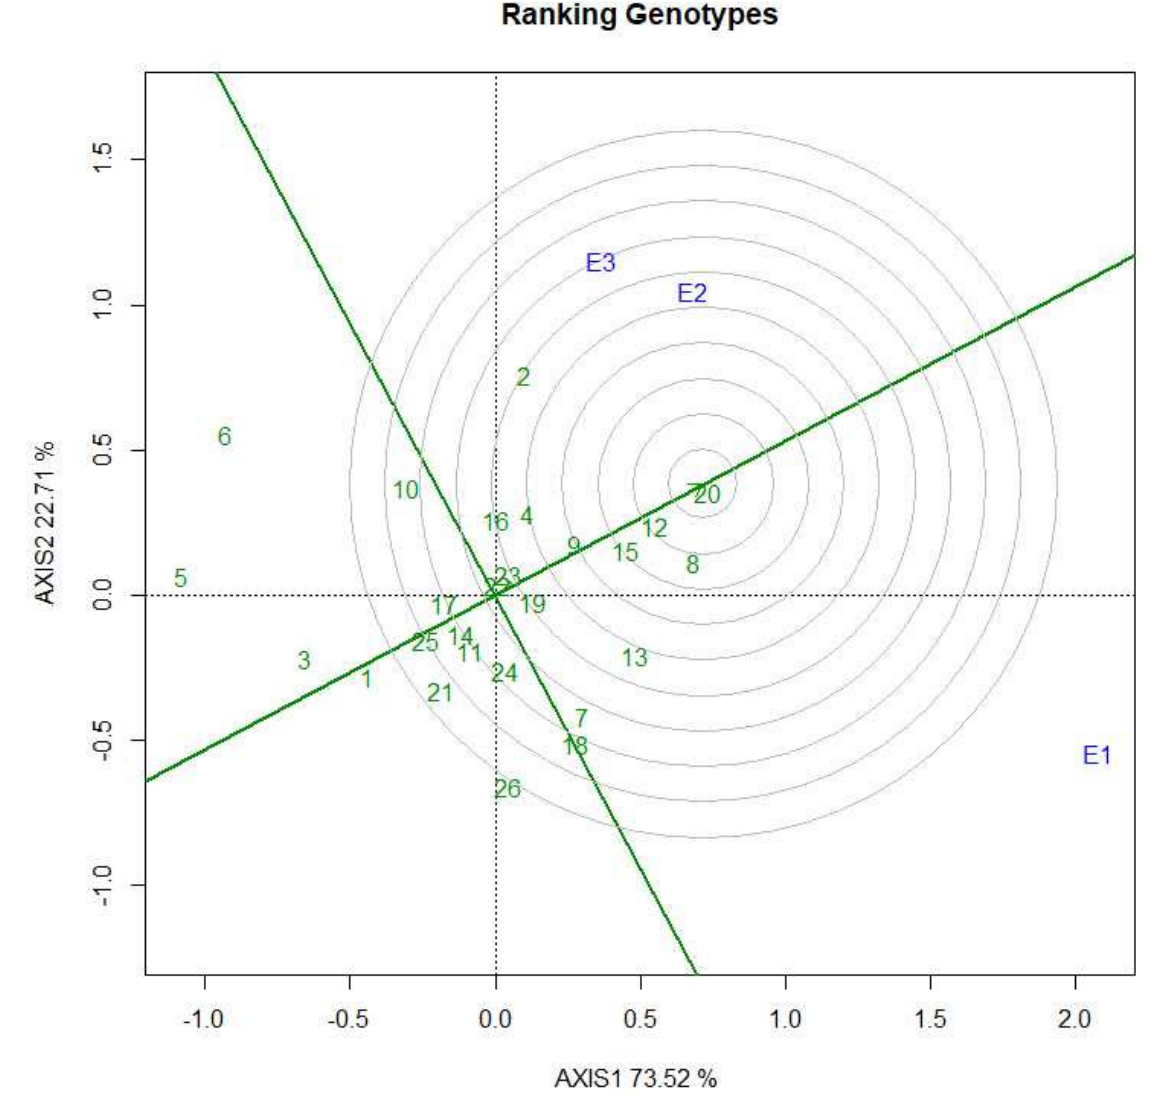
Figure 7. GGE biplot for ranking ideal rice hybrid combinations.